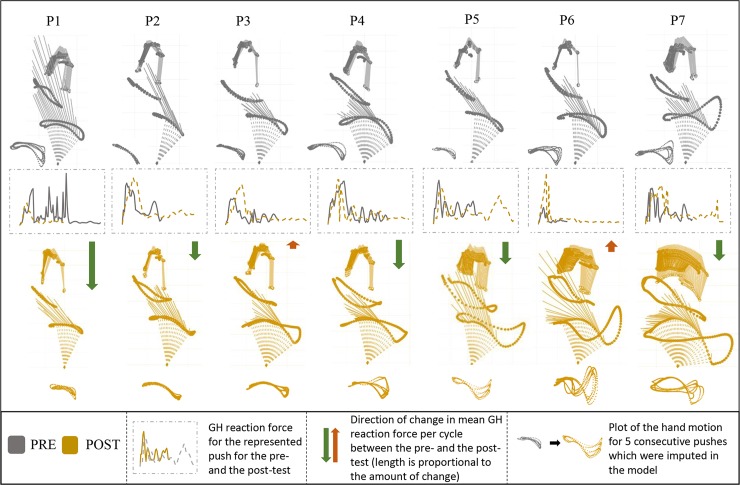
Typical example of one propulsive cycle for each participant (P1-P7) for the pre- (top) and the post-test (bottom section). The kinematic and kinetic input (reaction force vector) for the model in relation to the trajectories of the shoulder, elbow and hand over the push and recovery phase (cycle) for the pre- (grey) and the post-test (yellow) (row 1 and 3). Glenohumeral reaction force for the presented push for the pre- and the post-test (row 2). The illustrations of participants were sorted in ascending order based on the hand excursion at the post-test.